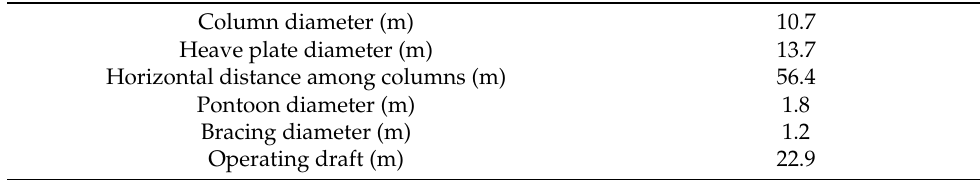
Table 1. Main dimensions of the floating platform under study (taken from